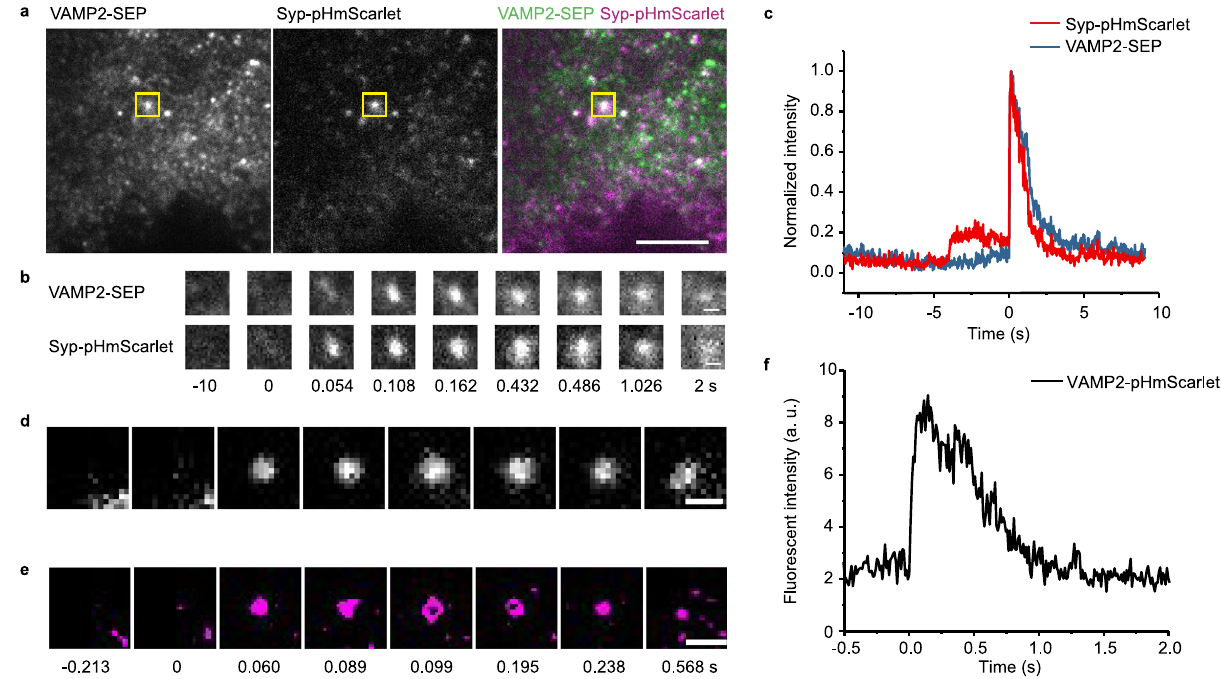
Fig. 6 Dual-color imaging of two vesicle membrane cargos and super-resolution imaging with pHmScarlet. a TIRF images of INS-1 cells expressing VAMP2-SEP and Syp-pHmScarlet. The locations of vesicle fusion are indicated by yellow rectangles, scale bar: 5 µ m. Experiments were repeated three times. b Time-lapses of the marked exocytotic events (bottom, 1.3 × 1.3 µ m), scale bars: 0.5 μ m. c Normalized intensity traces of the marked event in the green and red channels of the same vesicle. d Wide- fi eld TIRF image and e montages of a representative fusion event with ring structure in a VAPM2- pHmScarlet-labeled vesicle (magenta). Experiments were repeated fi ve times for ( d ) and ( e ). f Intensity traces of the marked event shown in ( e